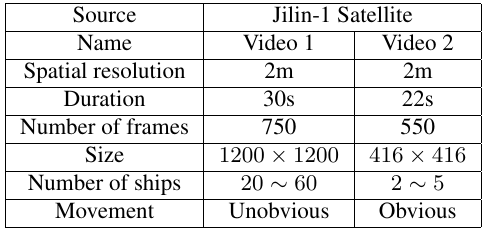
Table 2. The information of Jilin-1 satellite videos.